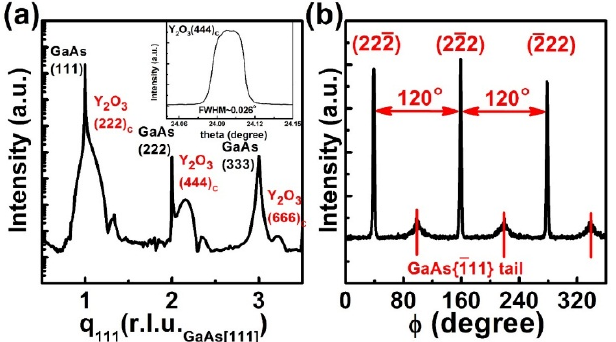
Figure 4. XRD ( a ) radial scans along the surface normal of ALD ‐ Y 2 O 3 films 2 nm thick on GaAs(111)A ‐ 2 × 2 reconstructed surface. The inset shows the θ‐ rocking curve across the Y 2 O 3 (444) reflection; ( b ) Azimuthal φ scan across the { 2(cid:3364) 22} reflections of the ALD ‐ Y 2 O 3 film 2 nm thick on GaAs(111)A ‐ 2 × 2 reconstructed